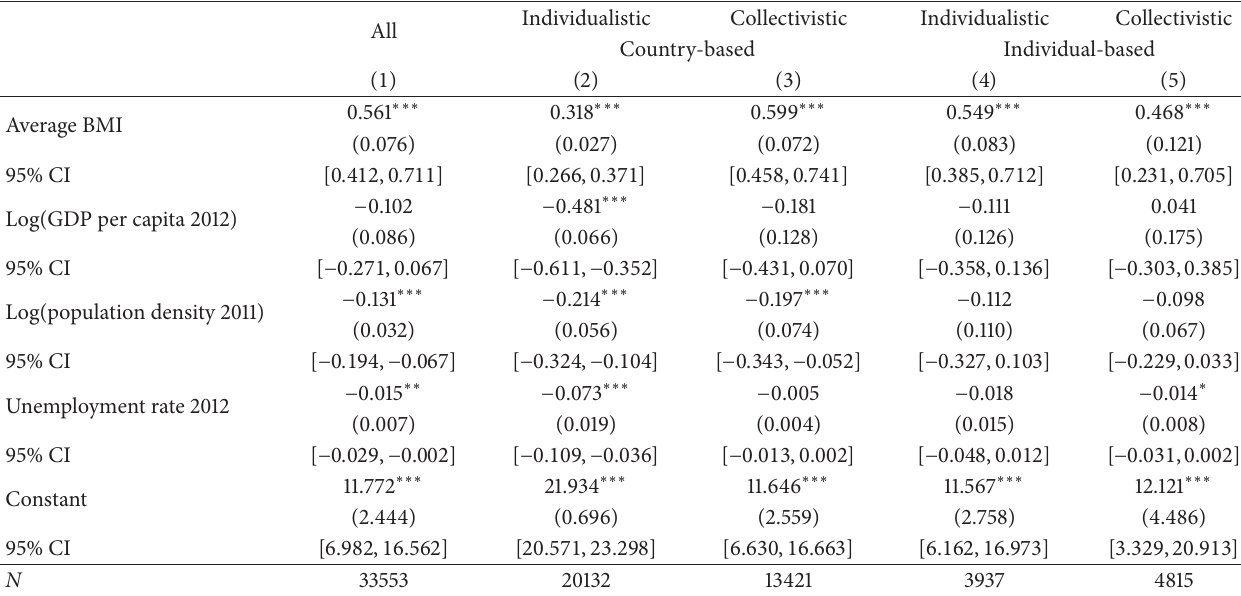
Table 3: MMEGLM estimates of average BMI on individual BMI (individualistic versus collectivistic, with GDP per capita, unemployment, and population density).